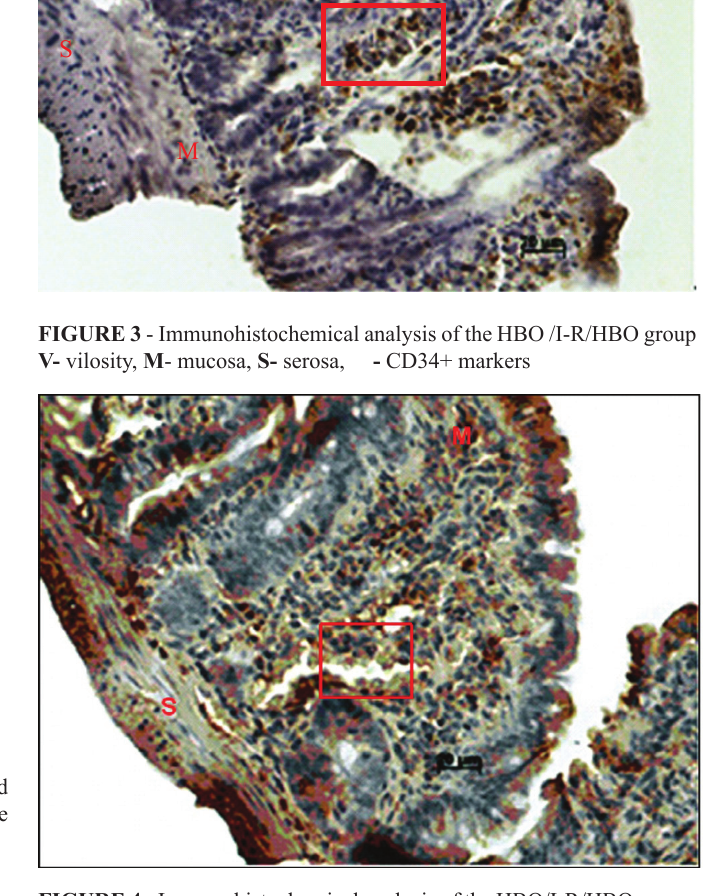
FIGURE 4 - Immunohistochemical analysis of the HBO/I-R/HBO group. M - mucosa, S- serosa, - VEGF